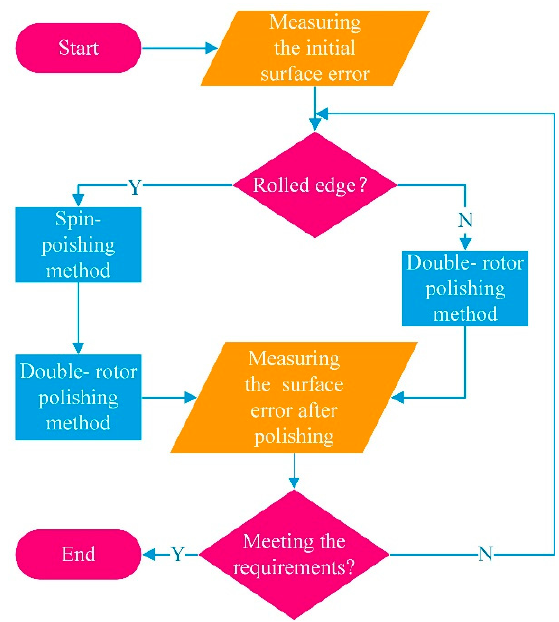
Figure 6. Combined polishing method.